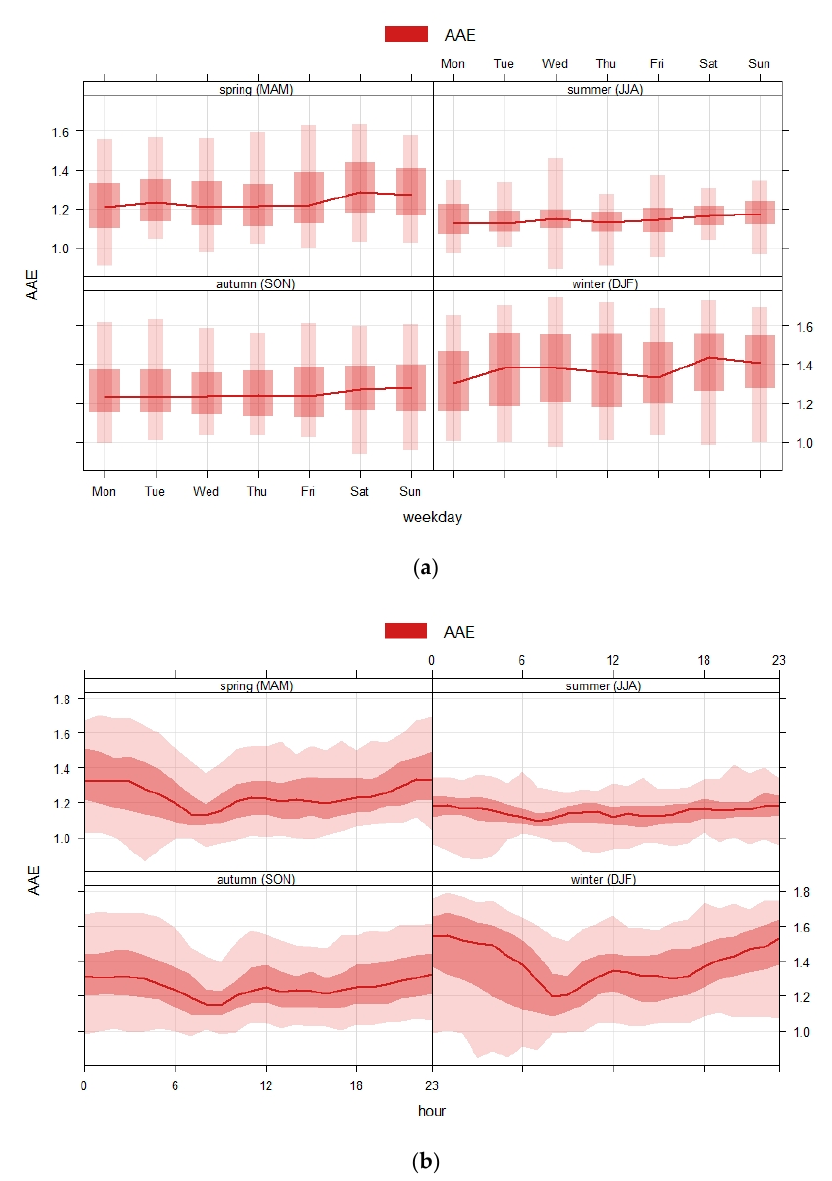
Figure 8. ( a ) Day of the week variation of absorption Ångström exponent (AAE). ( b ) Hour of day variation of AAE. The shading shows the extent of the 25/75th and 5/95th quantiles.